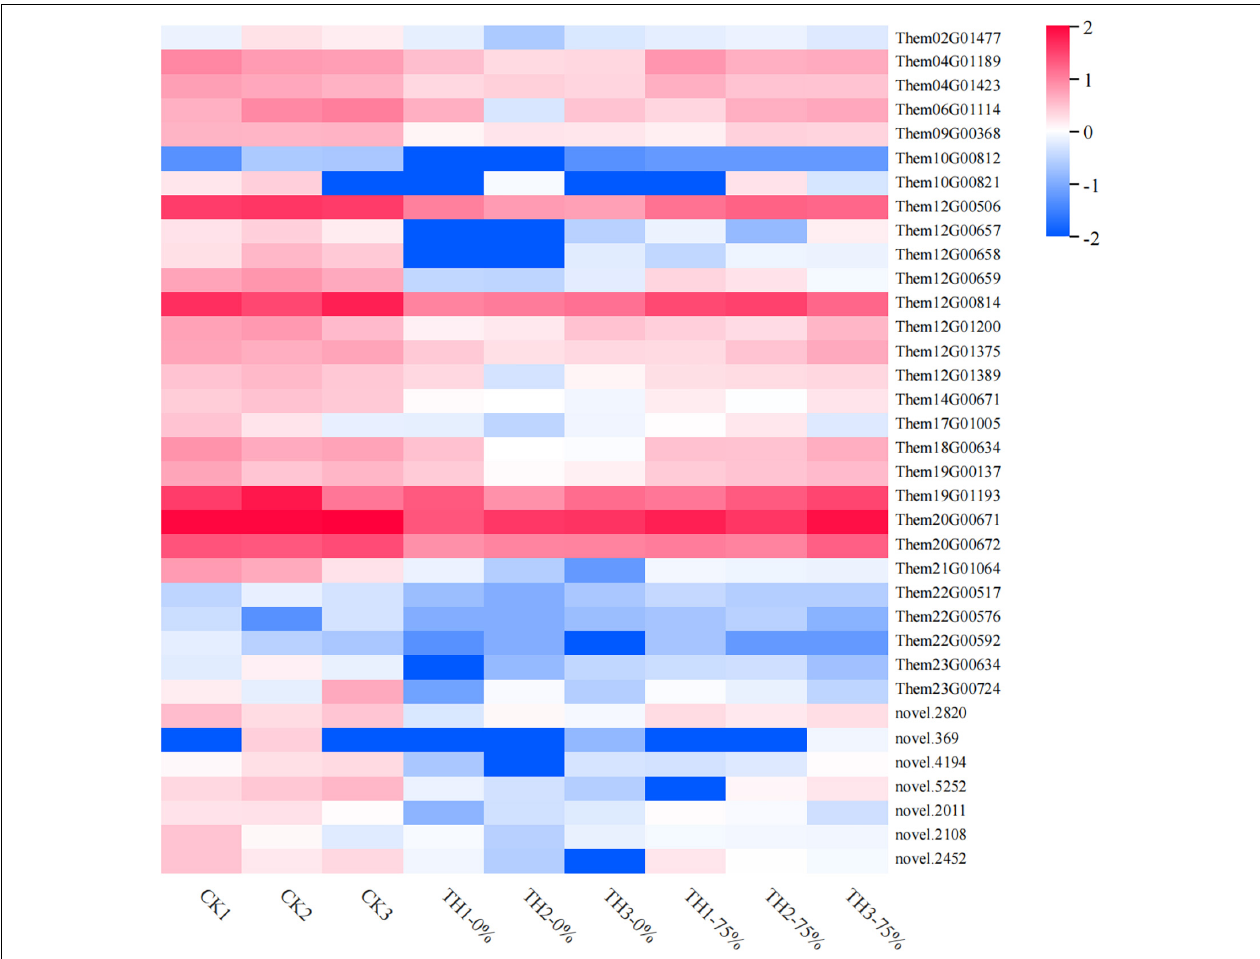
FIGURE 9 | Heat map visualization of the 35 genes in flavonoid metabolism-related pathways selected from profile 0. The color bar represents the log (fold change) values.